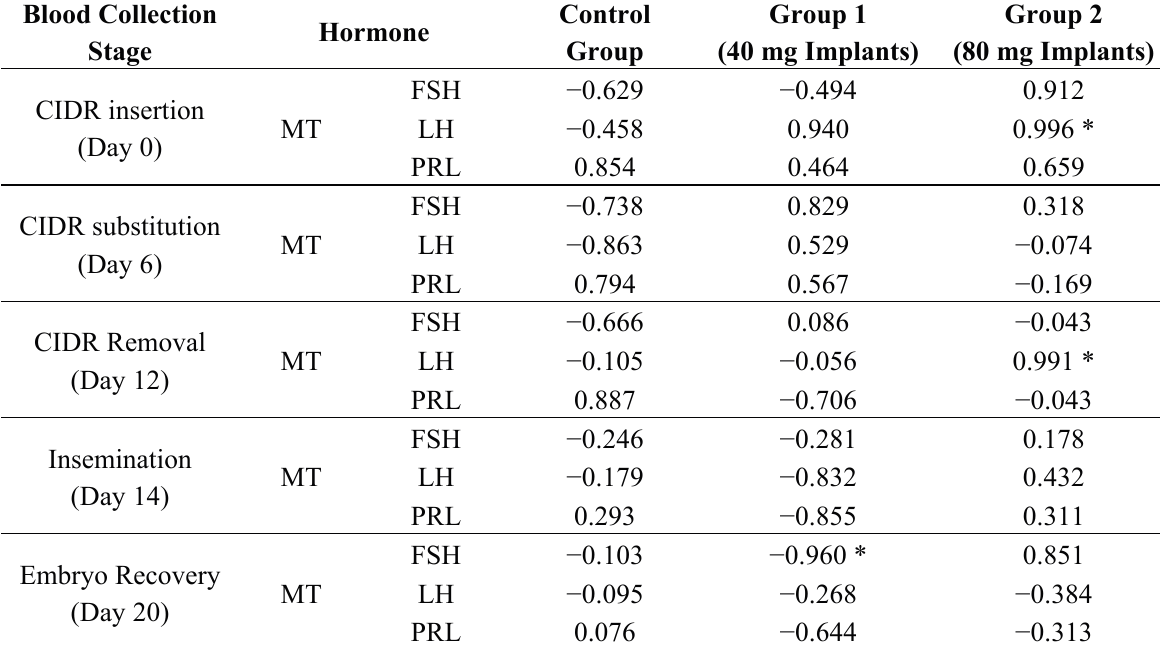
Table 1. The correlation coefficient of MT and FSH, LH and